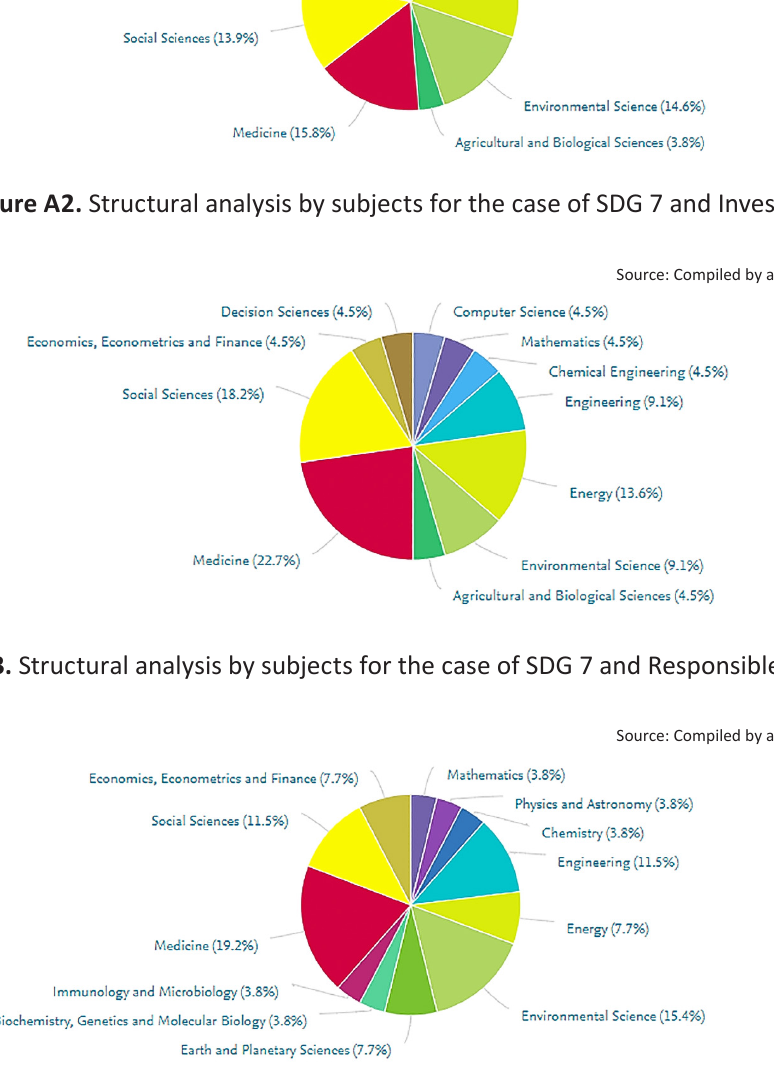
Figure A4. Structural analysis by subjects for the case of SDG 7 and Investment